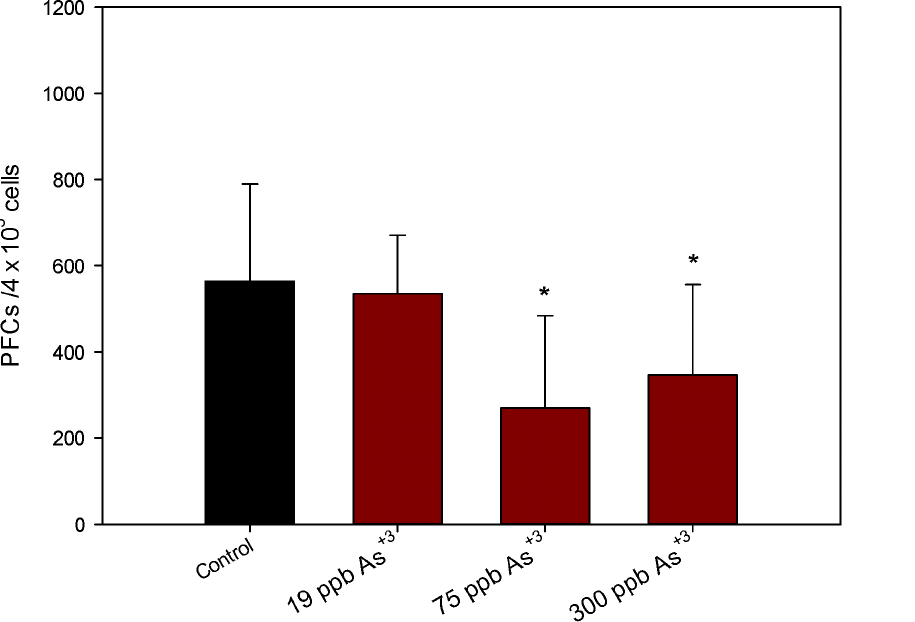
Figure 4. Suppression of T-dependent antibody response to sheep red blood cells post 30 day invivo exposure of mice to As + 3 via drinking water. After As + 3 exposure, mice were immunized with SRBCs and examined for in vitro antibody production 4 days later. Results are Means + SD.